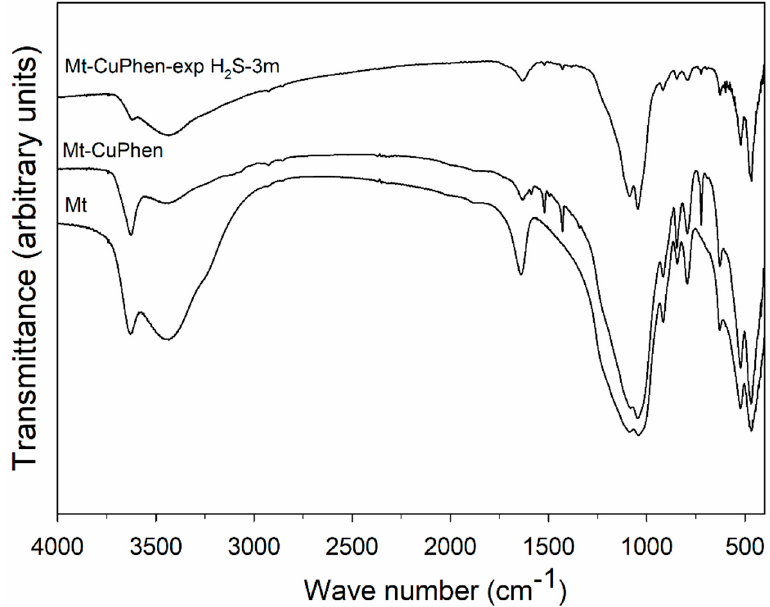
Figure 5. FTIR spectra for Mt-CuPhen before and after exposure to H 2 S for 3 months (Mt-CuPhen-exp H 2 S-3m). The Mt spectrum was also introduced as reported by Castellini et al.